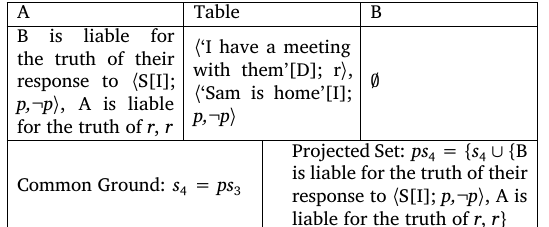
: A asserts “I have a Table 4 K 4 meeting with them”